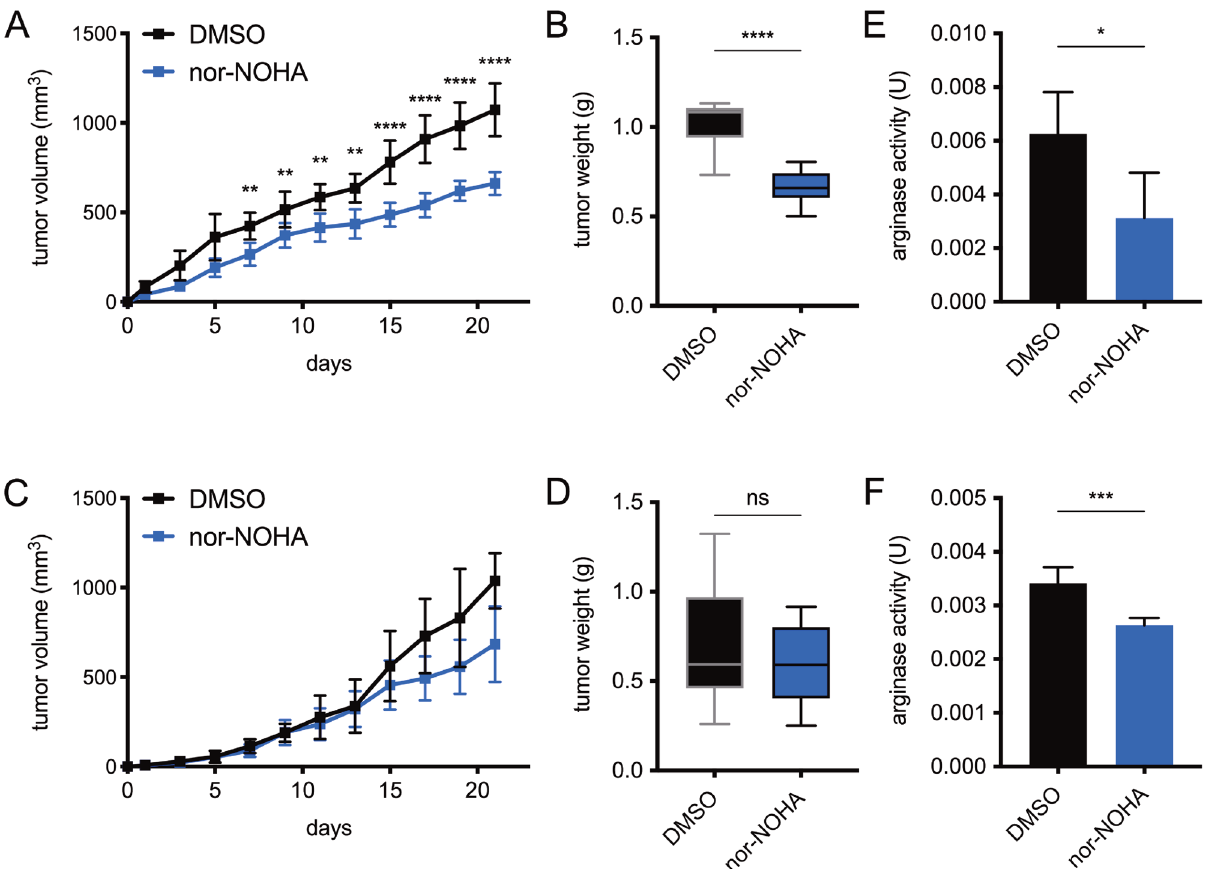
Figure 5. Transcutaneous arginase inhibition significantly reduces growth of PDVC57 tumors in immunocompetent but not immunodeficient mice. ( A ) Growth curves of treated PDVC57 tumors in immunocompetent B6 mice, with a significant difference by the end of week one. ( B ) Endpoint tumor weights of treated PDVC57 tumors in immunocompetent B6 mice, with a significant difference. ( C ) Growth curves of treated PDVC57 tumors in immunodeficient Rag1 KO mice, with no significant differences. ( D ) Endpoint tumor weights of treated PDVC57 tumors in immunodeficient Rag1 KO mice, with no significant difference. ( E ) Arginase activity as assessed by enzymatic fluorometric assay of treated PDVC57 tumors in immunocompetent B6 mice, which was significantly different indicating effective inhibition of arginase. ( F ) Arginase activity in units of catalytic activity (U) as assessed by enzymatic fluorometric assay of treated PDVC57 tumors in immunodeficient Rag1 KO mice, which was significantly different indicating effective inhibition of arginase. * P < 0.05; ** P < 0.01; *** P < 0.001; **** P < 0.0001 using the unpaired t -test adjusted for multiple comparisons. Three separate experiments with n > 5 per